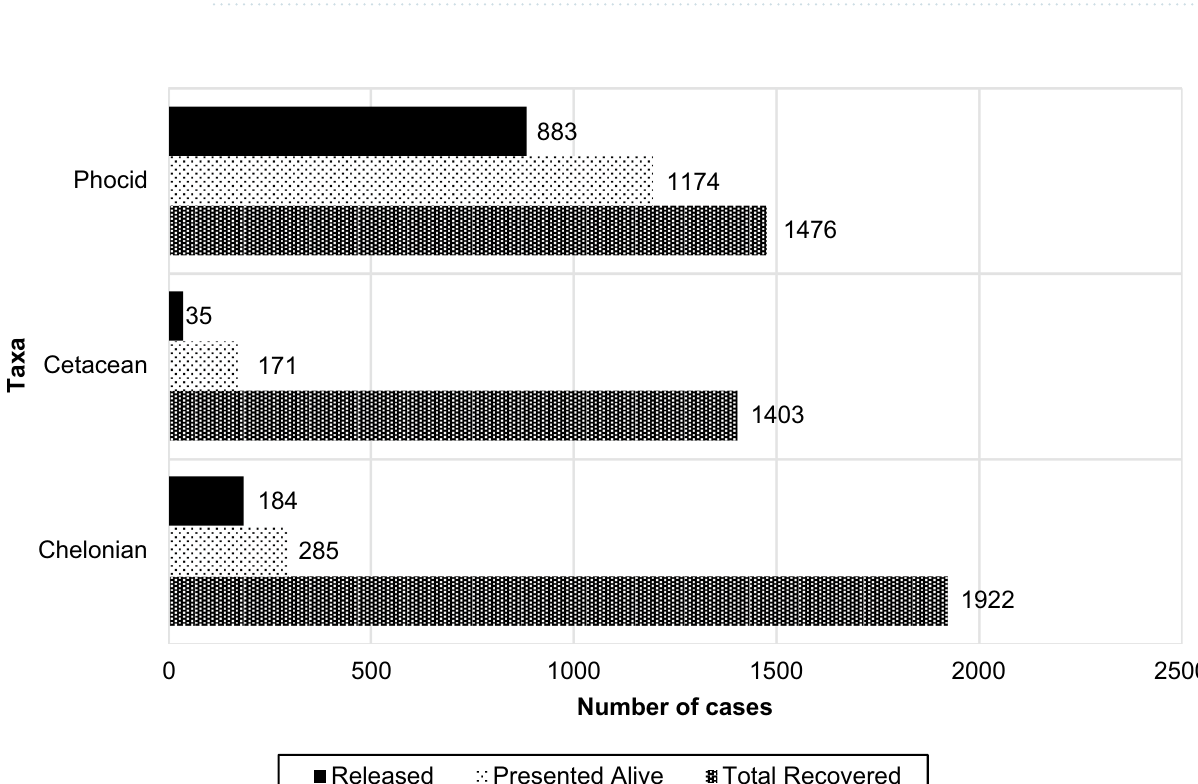
Figure 1. Number of cases with known outcomes per taxa of animals presented to the Marine Mammal Stranding Center in Brigantine, NJ between 1976 and 2016. Bars represented to the total number of animals presented, the proportion alive at presentation, and the proportion of live stranded animals that were released to their natural